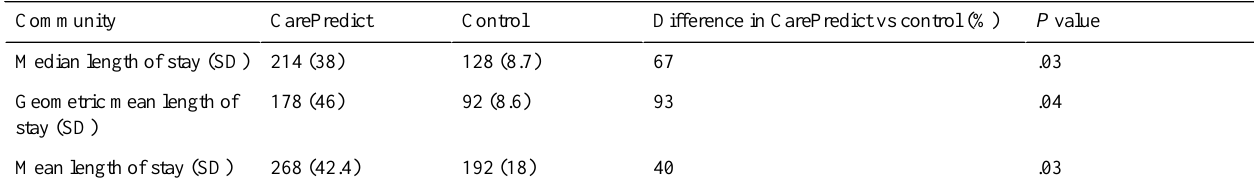
Table 4. Length of stay in CarePredict and control communities.